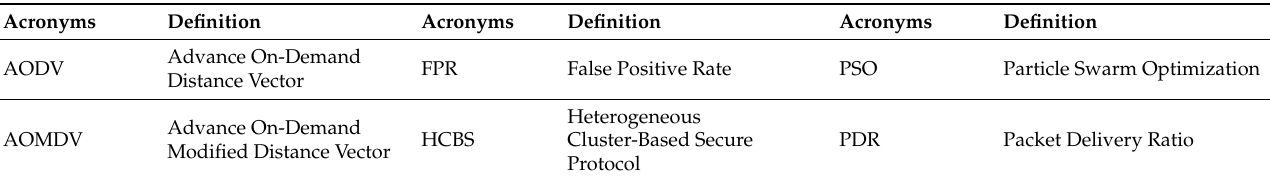
Table 2. Notations and their